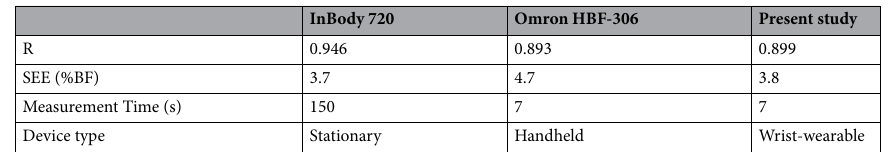
Table 3. Comparison of correlation coefficient and standard errors of estimate (SEE) of percentage body fat (%BF) among the whole-body composition analyzer (InBody 720), the upper-body portable body fat analyzer (Omron HBF-306), and our wrist-wearable bioelectrical impedance